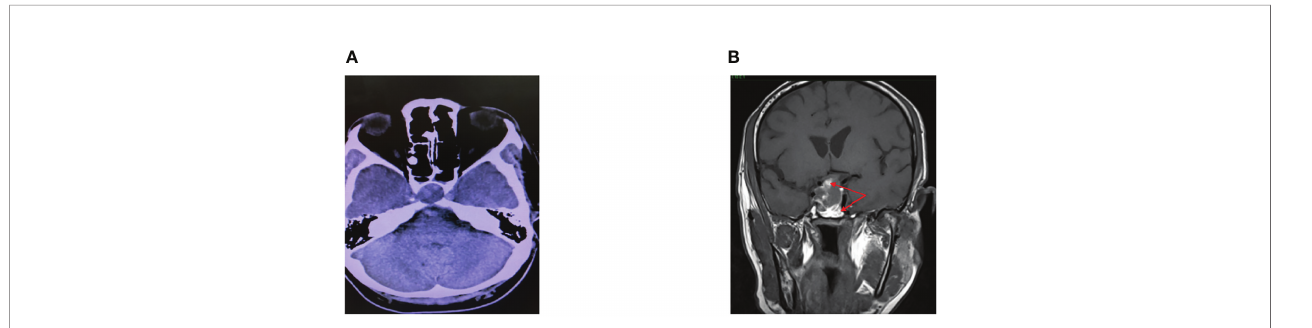
FIGURE 1 | (A) CT scan of the brain. (B) MRI pituitary T1 coronal